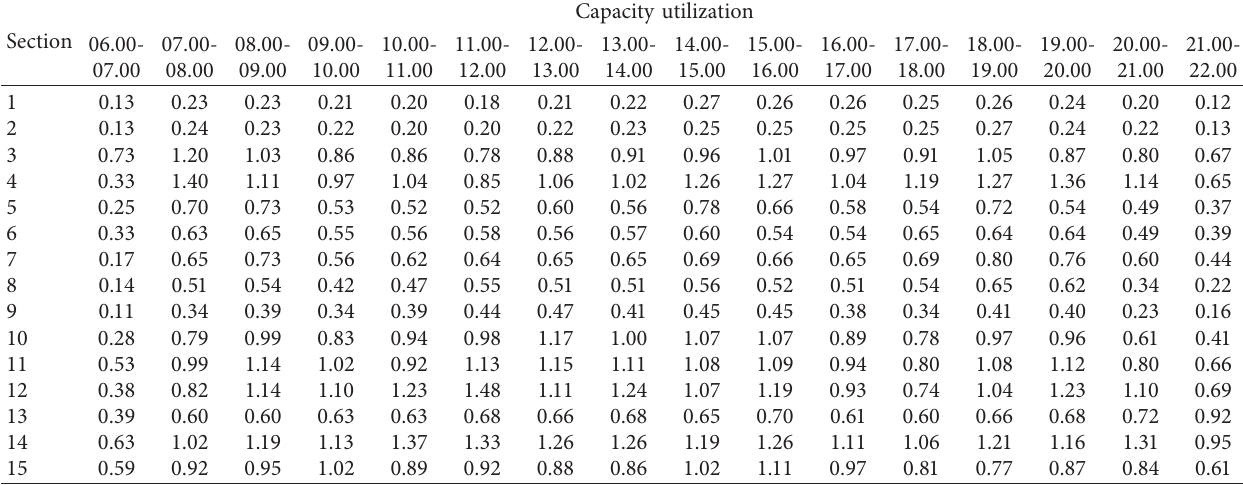
Table 5: Capacity utilization by sections and hours in a day for direction A.